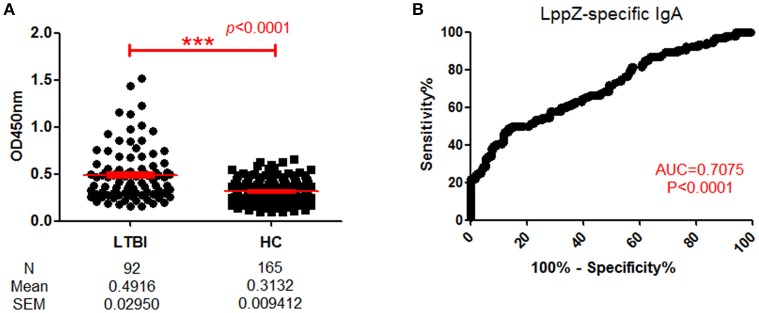
Determination of LppZ-specific IgA level in LTBI individuals. (A) OD450-values of LppZ-specific IgA in LTBI (N = 92) and HCs (N = 165). The P-value was calculated using Mann Whitney test. (B) ROC-curve for LppZ-specific IgA to discriminate LTBI individuals from HCs. The P-value was calculated using Mann Whitney test. AUC was 0.7075 (95% CI, 0.6396–0.7754). ***p < 0.001